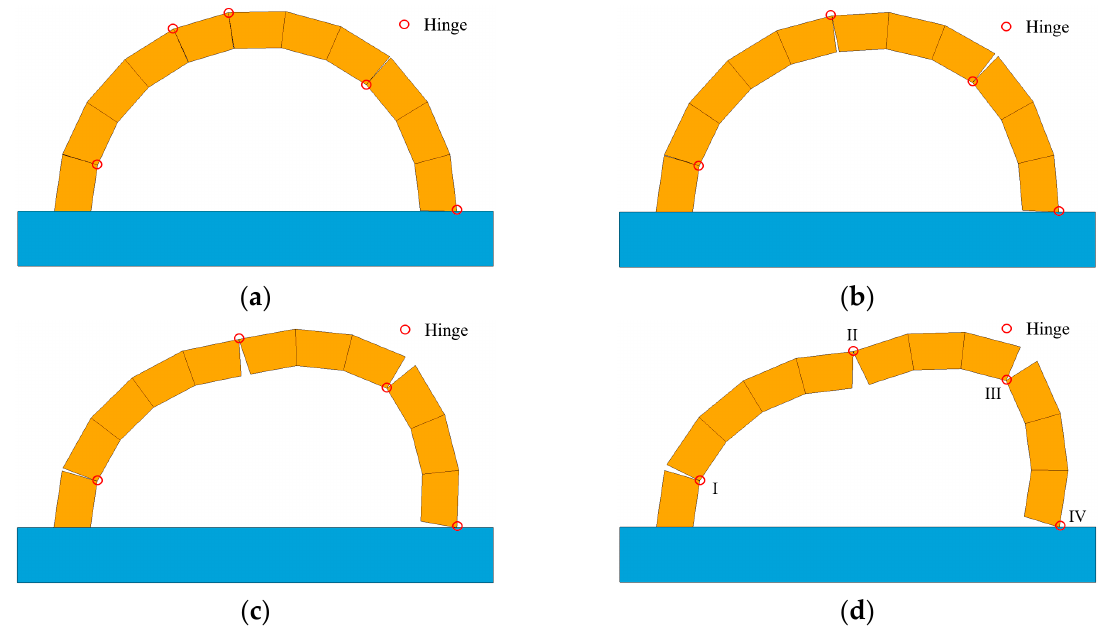
Figure 5. Failure process of the circular arch with β = 180°: ( a ) t = 0.5 s; ( b ) t = 0.65 s; ( c ) t = 0.85 s; ( d ) t = 0.95 s.